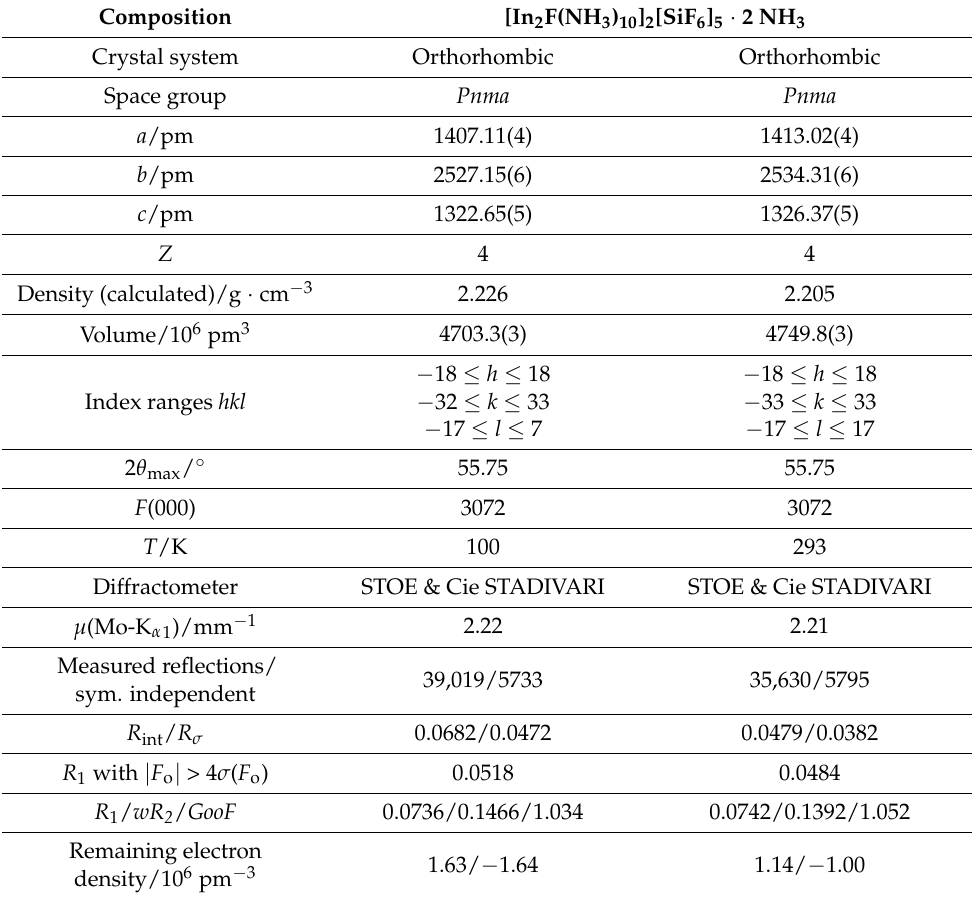
Table 2. Selected crystallographic parameters and refinement data of [In 2 F(NH 3 ) 10 ] 2 [SiF 6 ] 5 · 2 NH 3 at two different temperatures, collected on the identical single crystal. The positions of the hydrogen atoms could not be refined for the measurement at 293 K.